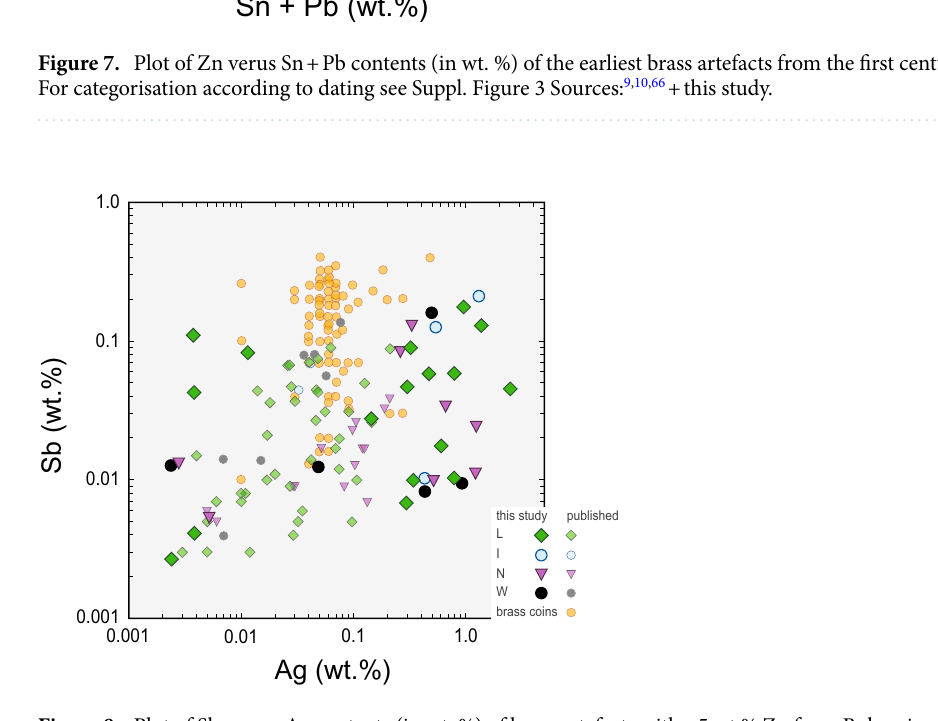
Figure 8. Plot of Sb versus Ag contents (in wt. %) of brass artefacts with > 5 wt.% Zn from Bohemia and Cambodunum with the Roman brass coinage categorised according to the cultural and chronological groups. Sources: this study; 65,66